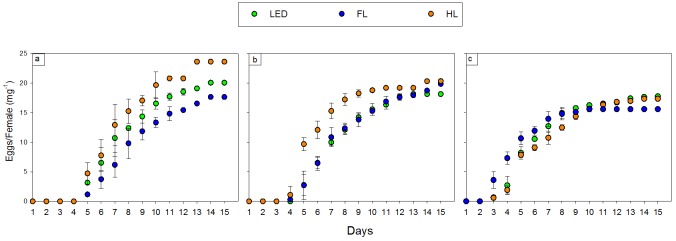
Accumulated egg mass per female (mg) and standard deviation for three artificial light sources: 1) light-emitting diode (LED, green); 2) fluorescent lamp (FL, blue); and 3) halogen lamp (HL, amber) during the 15 days for Experiment 1 [a], Experiment 2 [b], and Experiment 3 [c].